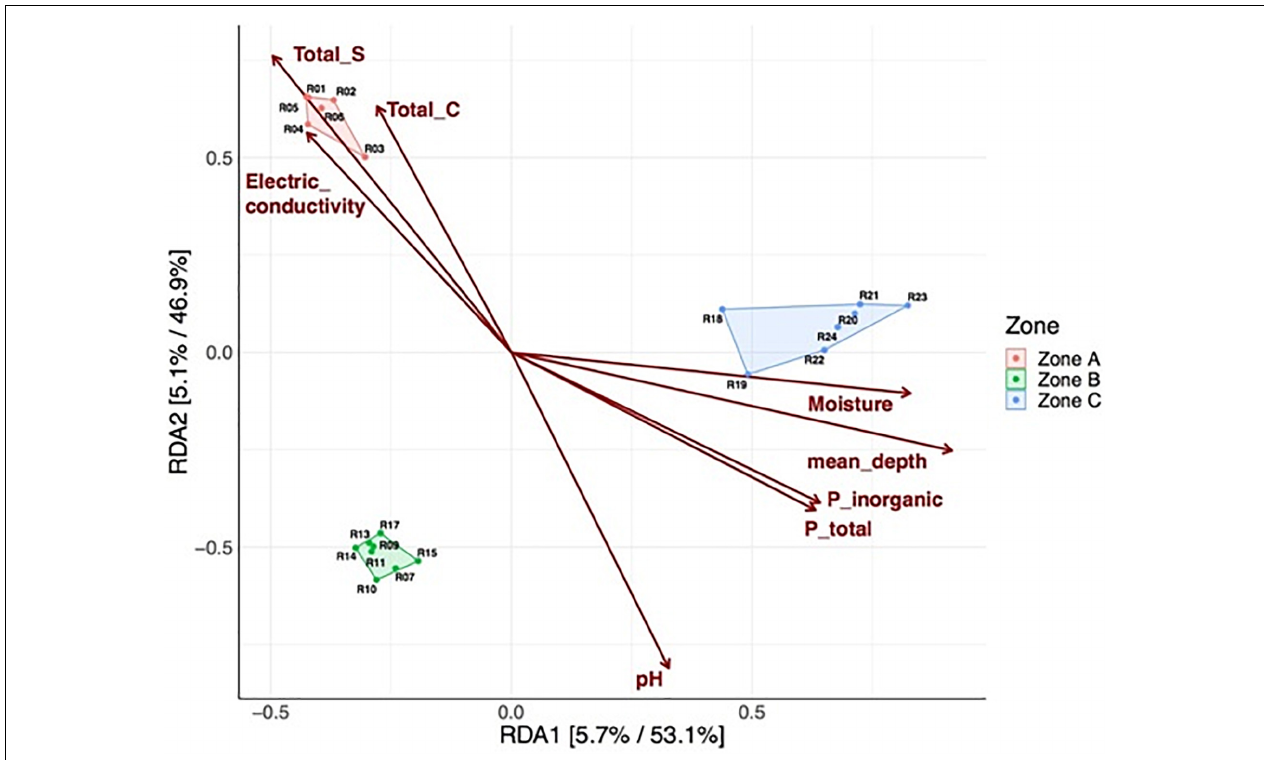
FIGURE 6 | Redundancy analysis (RDA) of Hellinger transformed amplicon sequence variant (ASV) relative abundances. Each point corresponds to a soil sample from a specific depth layer, and its relative distance indicates the level of similarity to all other samples. Polygons and colors label each of the three soil zones. The arrows indicate the explanatory power of the soil parameters concerning the observed variation in community composition. Insignificant soil parameters are not shown. For both axes, the percentages indicate the variance explained in the unconstrained and constrained analysis. Total sulfur (TS), total carbon (TC), total phosphorus (P_Total), unreactive phosphorus or inorganic phosphorus